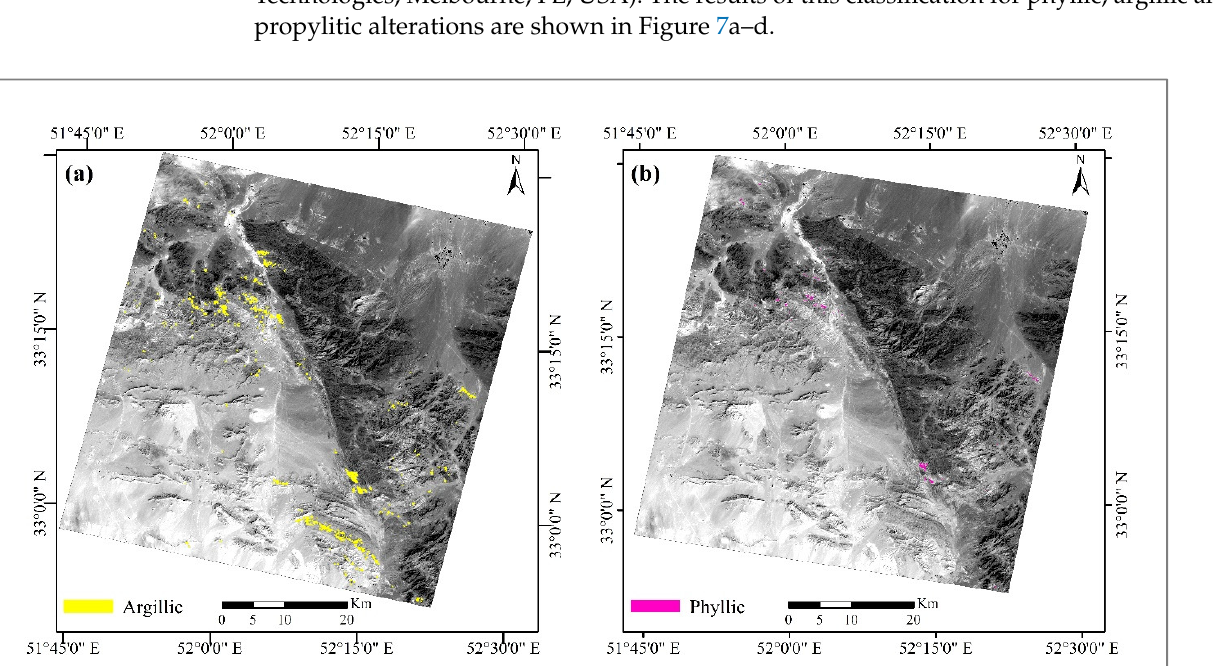
Figure 7. The results of SVM on the ASTER data. ( a ) Argillic alteration, ( b ) phyllic alteration, ( c ) propylitic alteration, and ( d ) Fe-oxide alteration. 4.5. Implementation of the SAM on ASTER Data The SAM classification was used to compare the efficiency of the SVM results. DP clustering data was used as the training data for this algorithm. Phyllic, argillic, and prop- ylitic alteration zones were mapped using the SAM algorithm on the ASTER image. The selected SAM spectral angles (in radians) used in this study were: α = 0.4 for phyllic alter- ation, α = 0.25 for argillic, and α = 0.3 for propylitic. The results of the SAM classification are shown in Figure 8a–d.